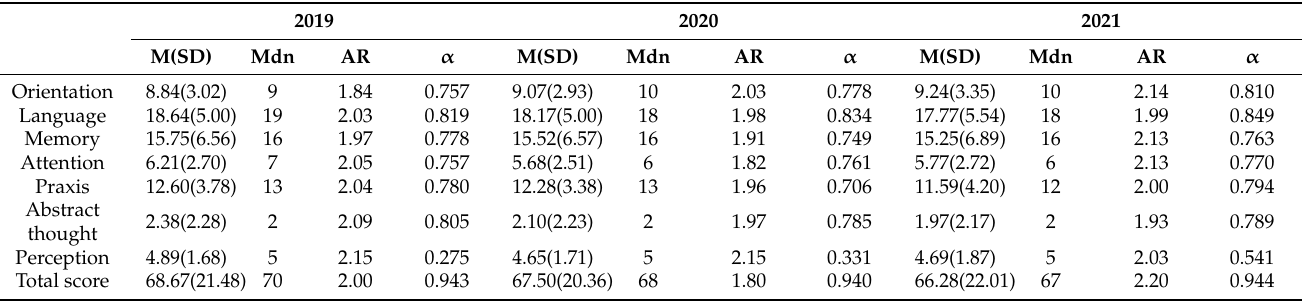
Table 2. Descriptive statistics and value of Cronbach’s α . CAMCOG-DS